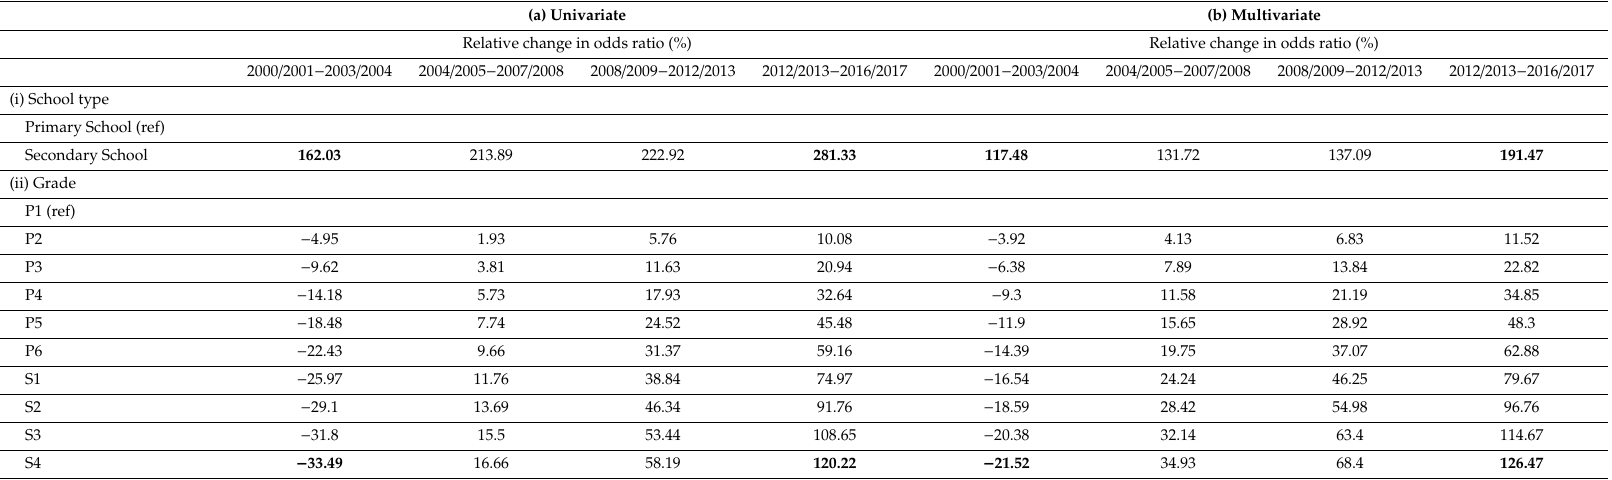
Table 4. Relative change in odds ratio of school type (and grade) on reduced visual acuity before and after adjusting for age in logistic